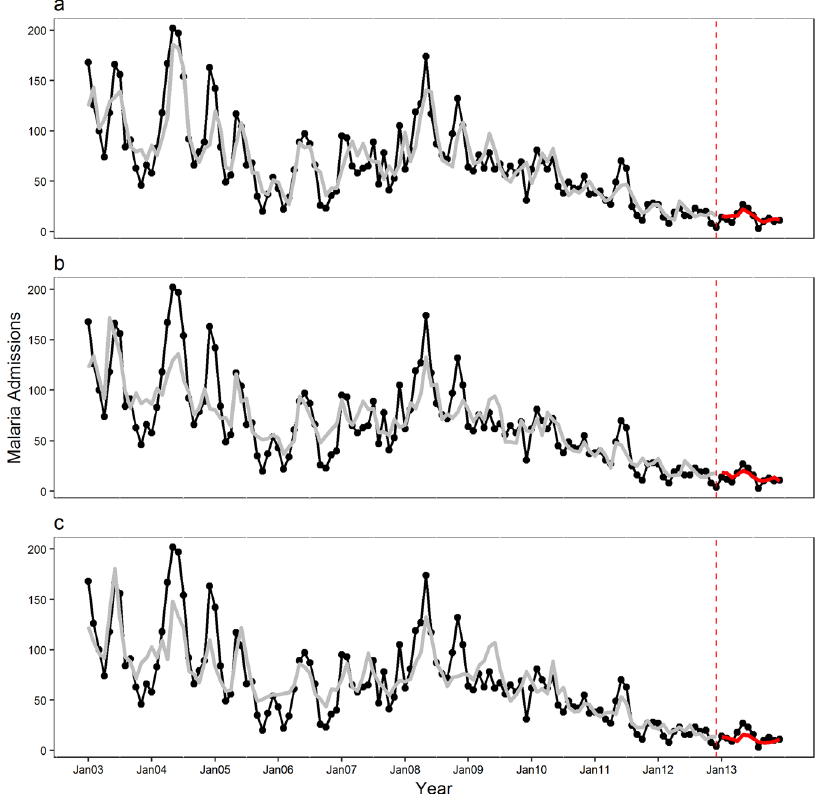
Figure 3. Observed and predicted pediatric malaria admissions at Siaya district hospital, Western Kenya by prediction lead time for the period 2003–2013 from the GAMBOOST model. ( a ) The 1-month, ( b ) the 2-month and ( c ) the 3-month prediction lead times respectively. The black line displays observed malaria admissions, the grey line predicted values during the training period 2003–2012, and the red line the 2013 forecasted values. The dotted red line marks the beginning of the test